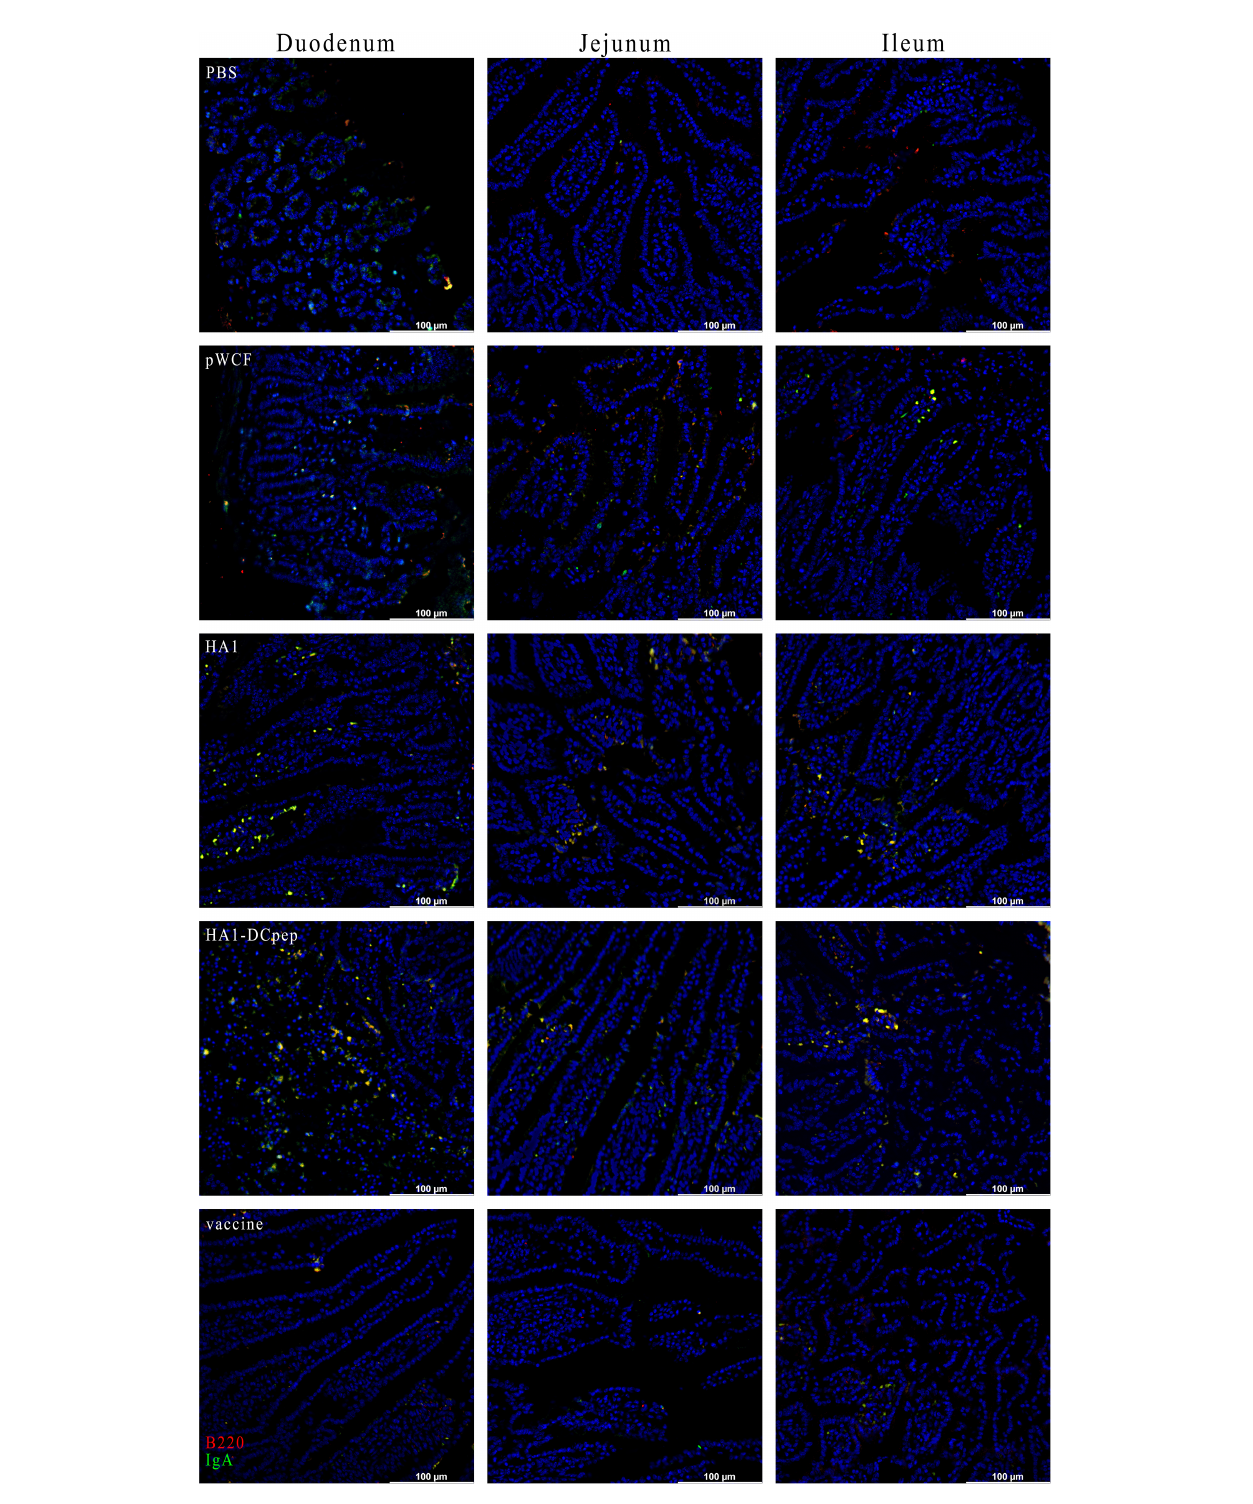
FIGURE 8 | Recombinant L. plantarum increase IgA expression in the intestine of mice. After oral immunization of mice with recombinant L. plantarum , IgA expression was measured in different sections (duodenum, jejunum, and ileum) using anti-B220 (red) and IgA (green) antibody staining and immuno fl uorescence technique. Intestinal segment scale bars represent 100 m